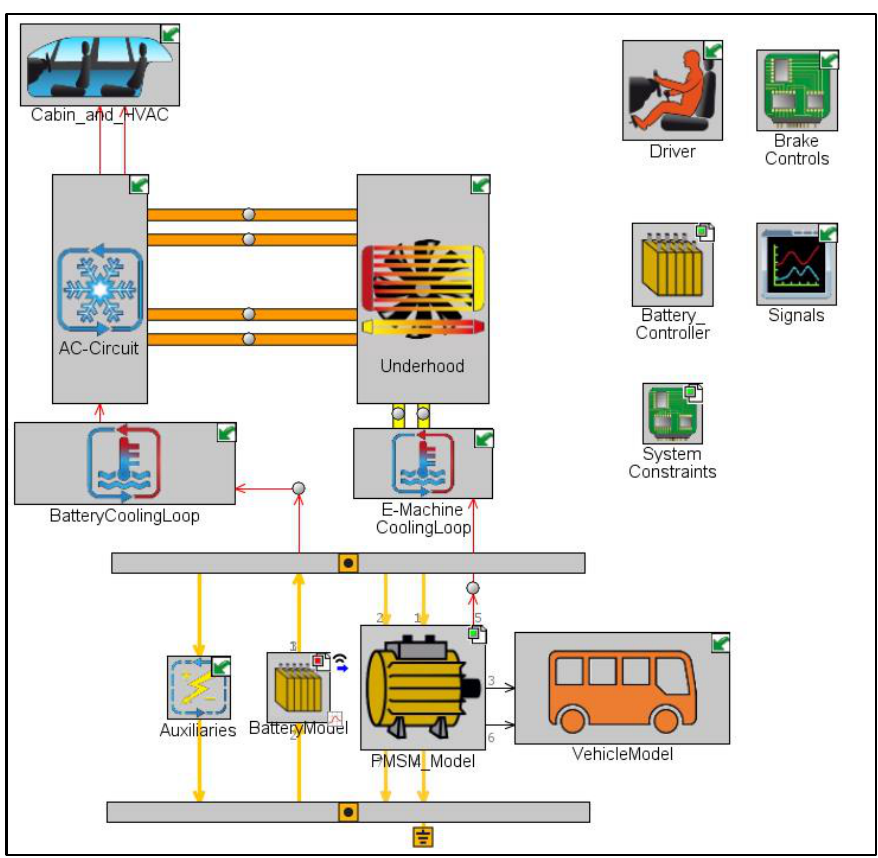
Figure 1. The global model of the battery electric bus in GT-ISE.